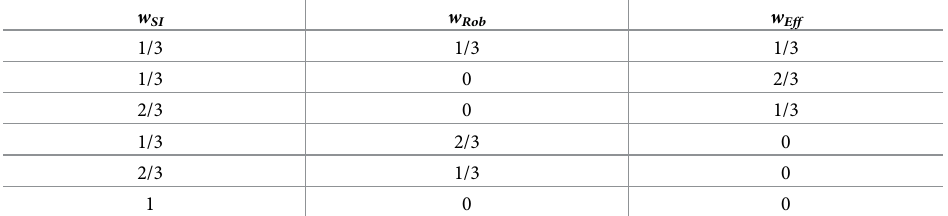
Table 2. Weight’s set used to compute the weighted cost function D . w SI w Rob w Eff 1/3 1/3 1/3 1/3 0 2/3 2/3 0 1/3 1/3 2/3 0 2/3 1/3 0 1 0